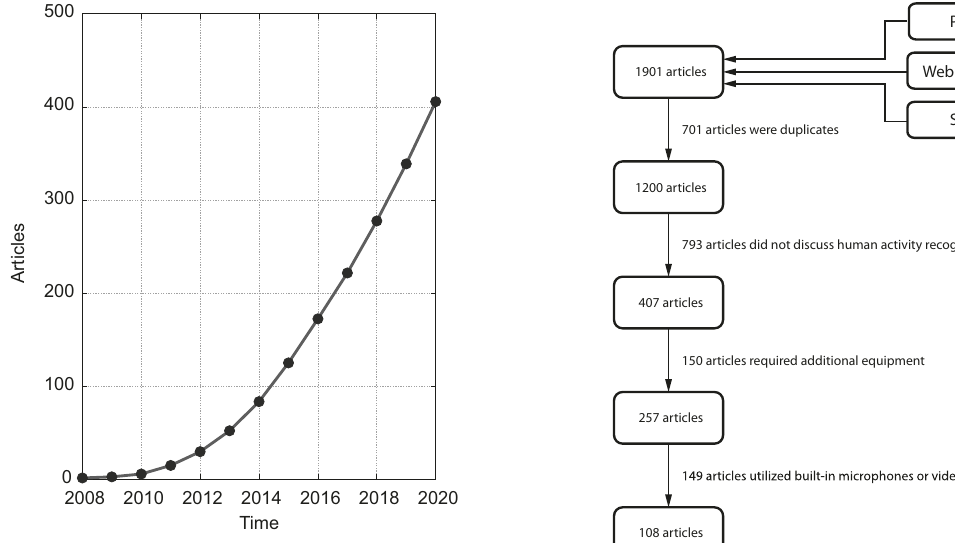
Fig. 1 Cumulative number of peer-reviewed articles on human activity recognition (HAR) using smartphones. Articles were published between January 2008 and December 2020, based on a search of PubMed, Scopus, and Web of Science databases (for details, see “ Methods ” ).